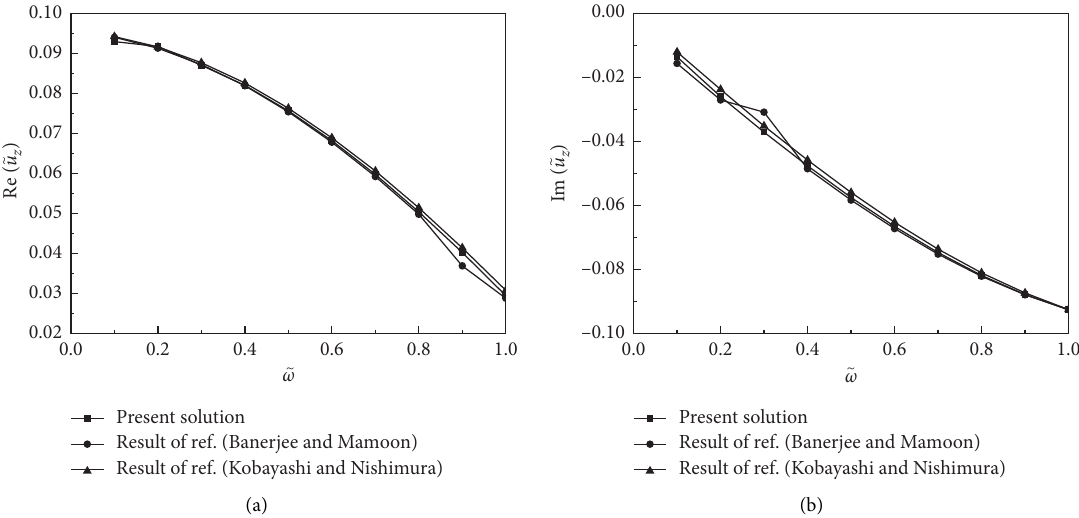
Figure 4: Compared present solutions with the reference’s results: (a) real part of vertical displacement and (b) imaginary part of vertical